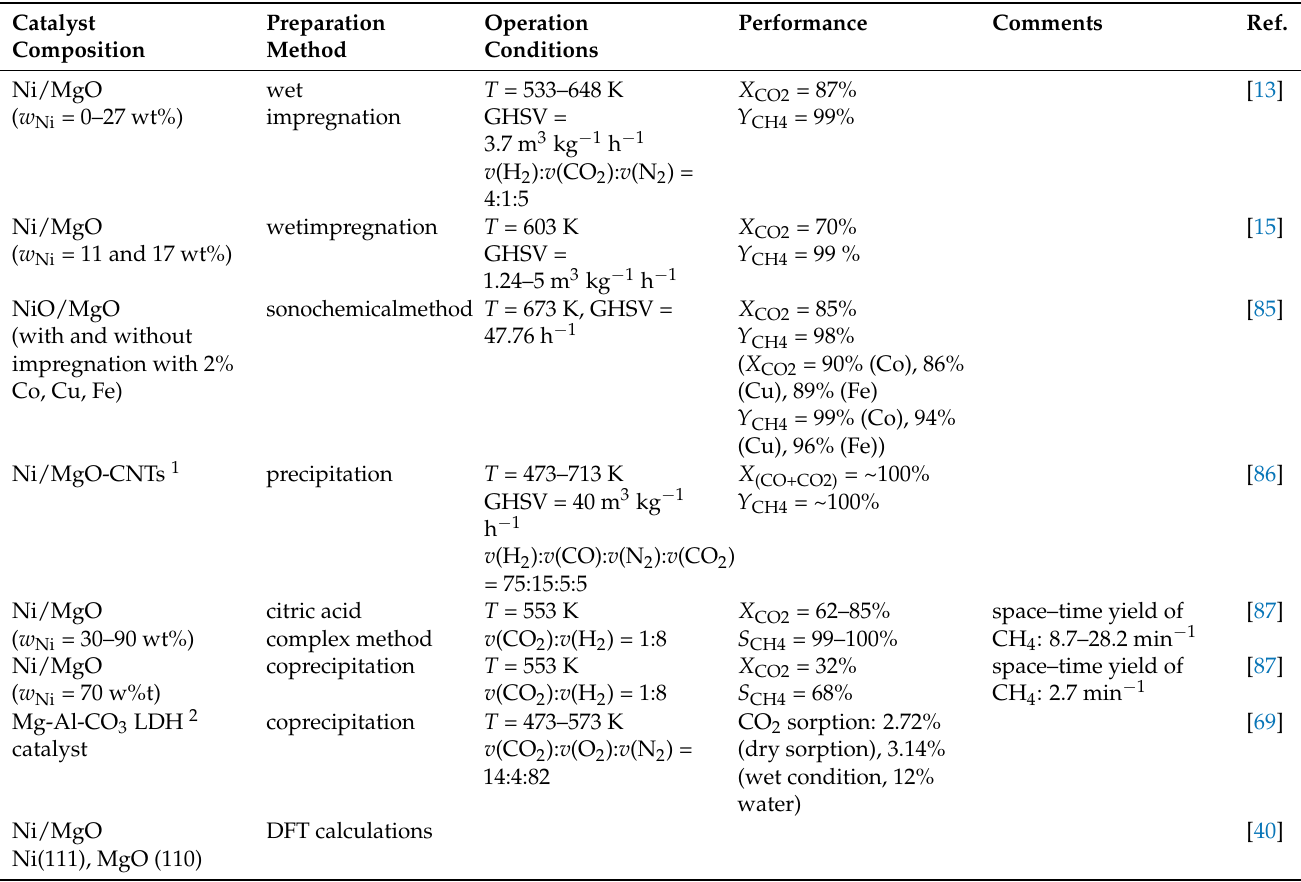
Table 1. Experimental studies using Ni-based catalysts on MgO carrier material for CO 2